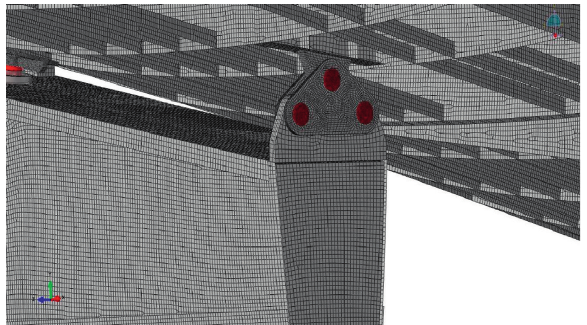
Figure 4: FE model of separation structure.